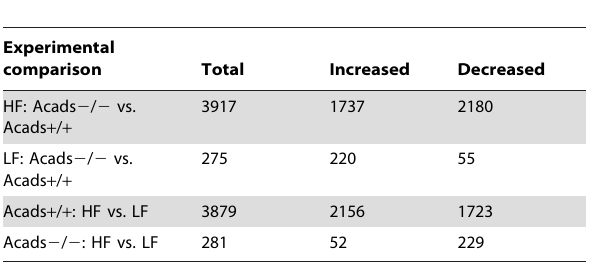
Table 1. Summary of differentially expressed genes.